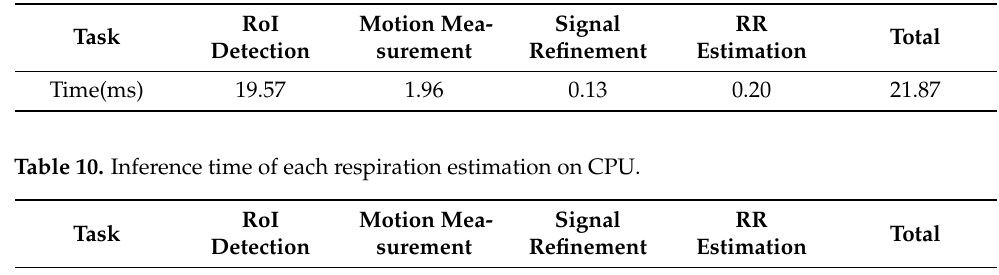
Table 9. Inference time of each respiration estimation on GPU.